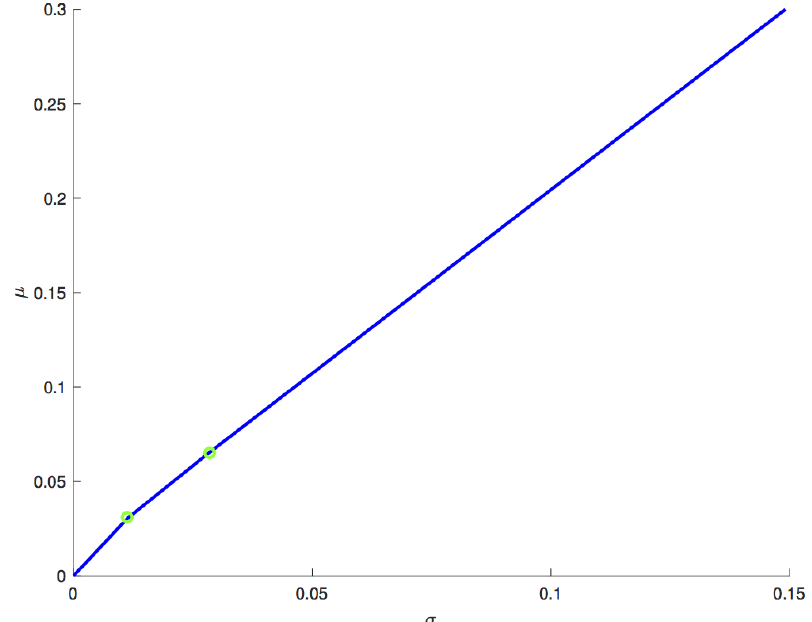
Figure 3. Comparison between leveraged portfolio with the classical Markowitz’s portfolios with the statistical hypotheses of Equations (41), (42) and